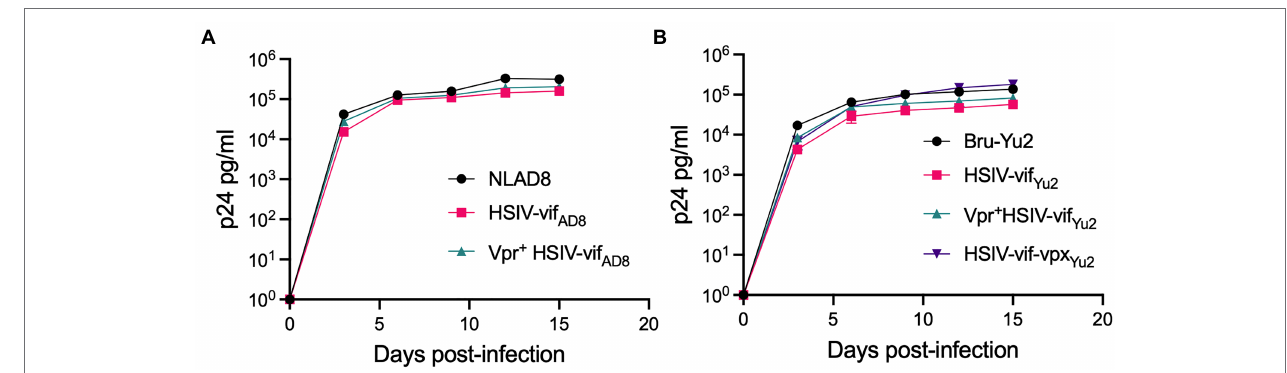
FIGURE 5 | Vpr and Vpx expressing HSIV replicate in monocyte-derived macrophages (MDMs). Cells were infected in duplicate with HSIV-vif AD8 (A) and HSIV-vif Yu2 (B) clones expressing Vpr or Vpx or neither at an MOI of 0.01. Virus supernatants were collected every 3–4 dpi and assayed for p24